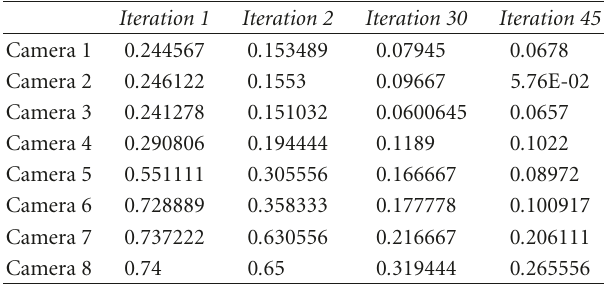
Table 5: Mis Err t i rates during incremental learning initial train- ing set = 4800.